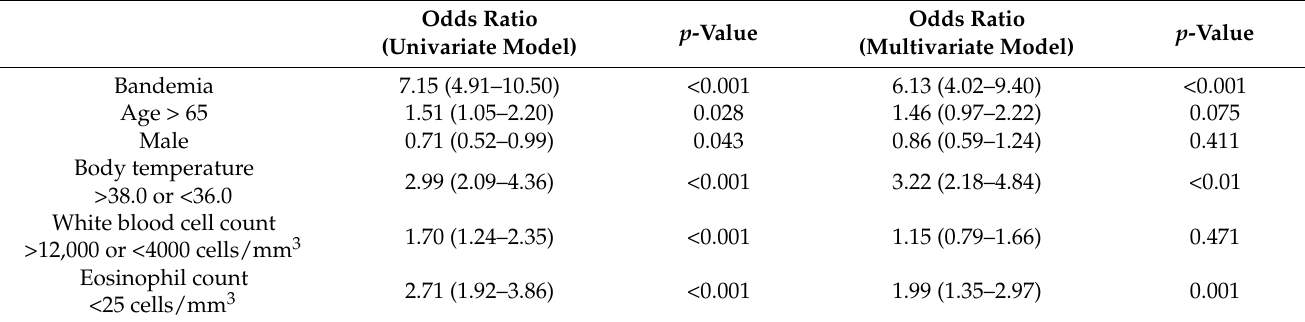
Table 3. Odds ratios of variables for predicting